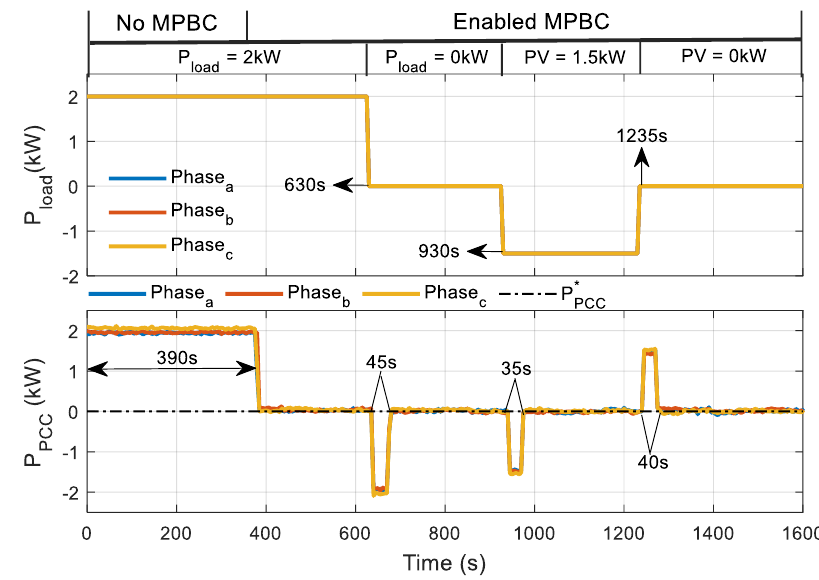
Figure 5. Load power and PCC active power during self-consumption mode.